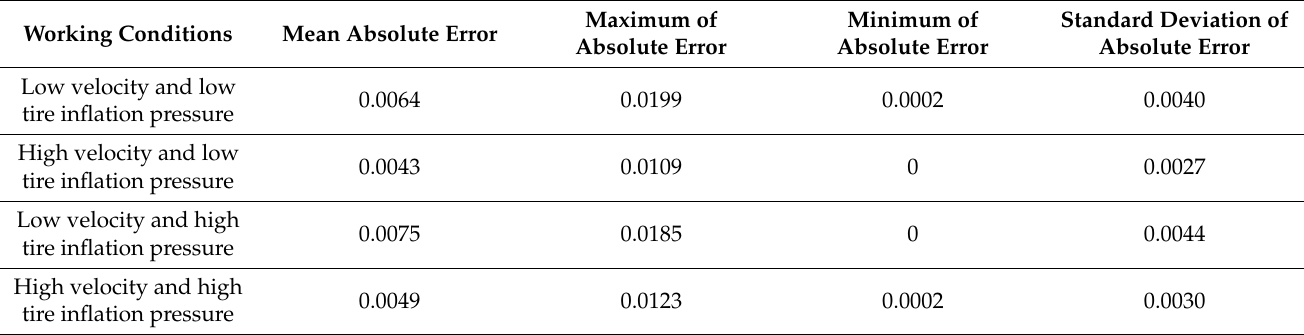
Table 6. In various working conditions of the soft soil ground, the absolute errors of the slip ratio for the tractor driving wheels were obtained by comparing the machine vision method with the GPS